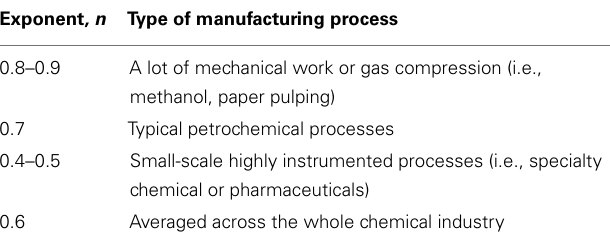
Table 2 |The range of exponents typically used in the exponent based cost estimation methods (Towler and Sinnott, 2013)